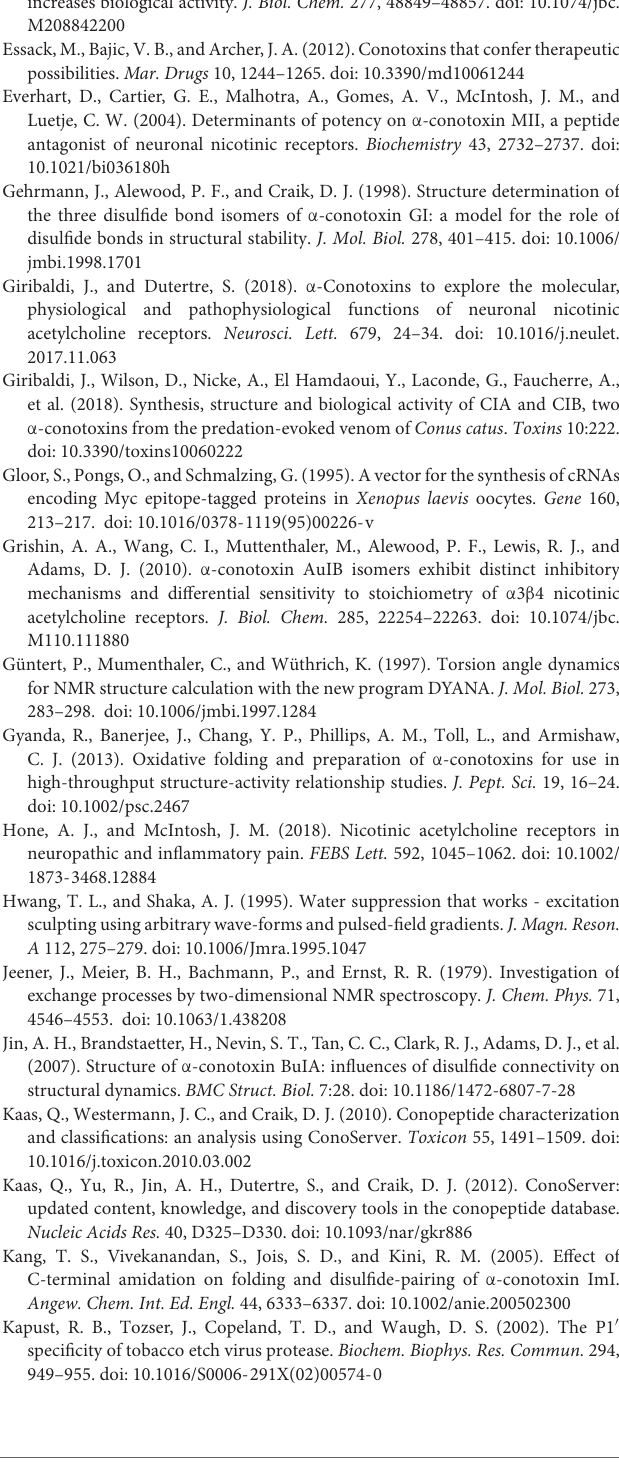
ToxDock-refined molecular models. The α 7 nAChR is in blue and the toxins in orange. Hydrogen bonds are represented using dashed lines. DATA SHEET S1 | Atomic coordinates files in PDB format of the molecular models of the interaction between ribbon TxIA and the α 7 nAChR. Two models are provided, one refined using a molecular dynamics simulation and the other refined using the ToxDock